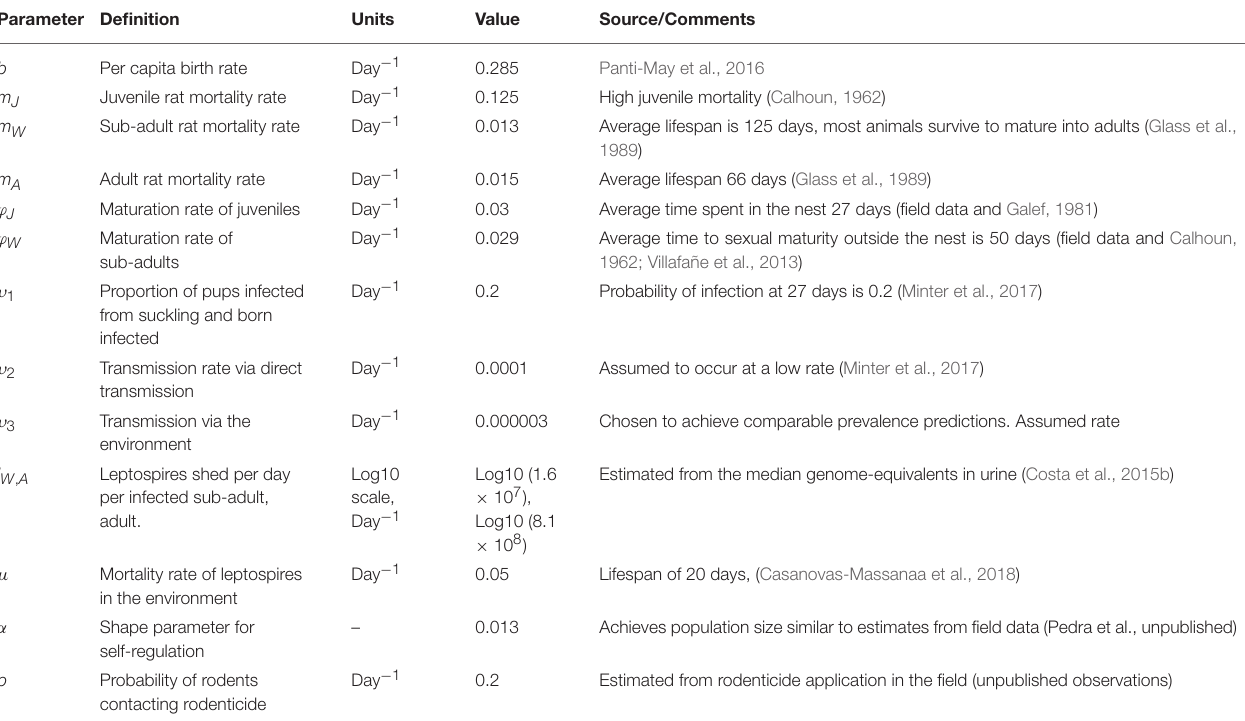
TABLE 1 | Parameter definitions and values for the age-structured